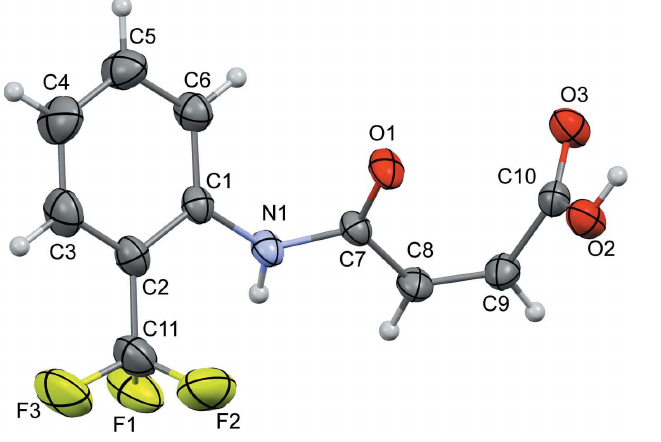
Figure 2 A view down [010] of the crystal packing in (I) showing the sheets of molecules linked by O—H (cid:3)(cid:3)(cid:3) O and N—H (cid:3)(cid:3)(cid:3) O hydrogen bonds and C— H (cid:3)(cid:3)(cid:3) O interactions (thin blue lines).